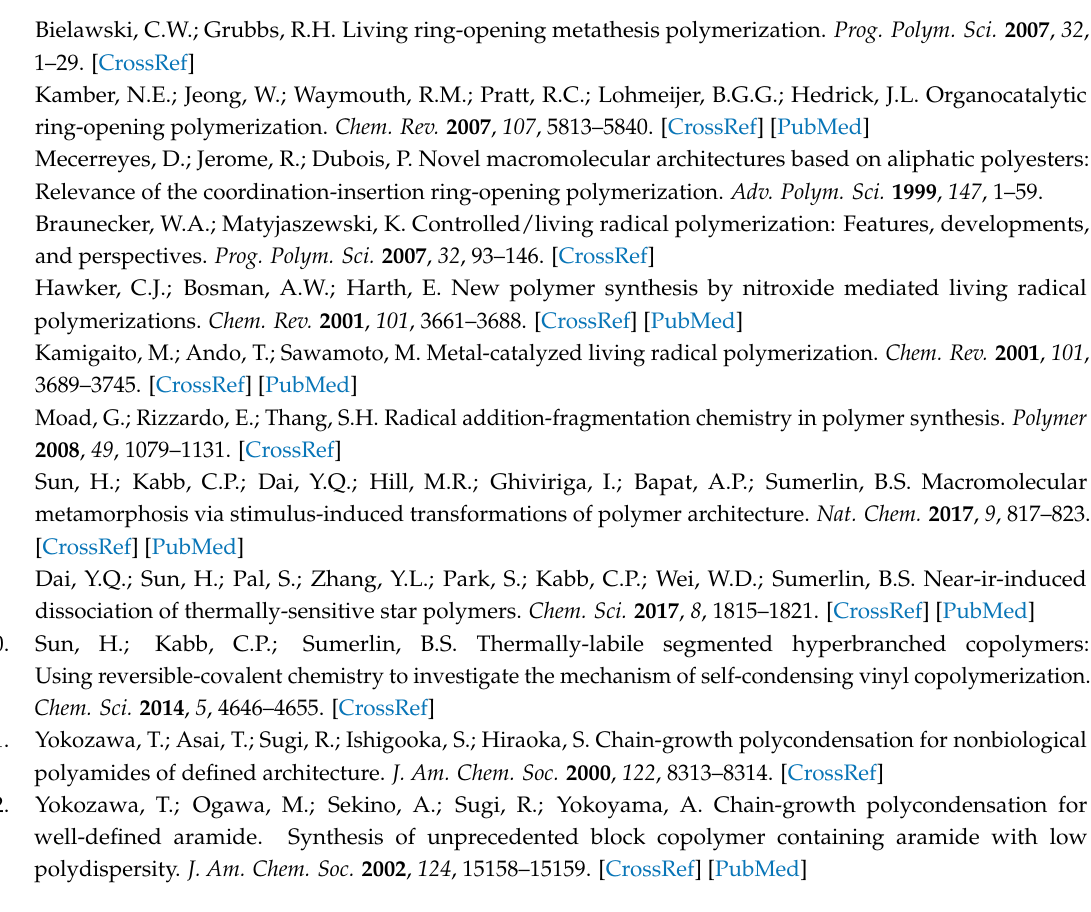
Table S1: Various inserted VBC units after SA ATRC of PCL–Br: estimated (Cal.) and measured (Exp.) m / z values in Figure 3, Table S2: Summary of rate constants based on initiators of EBiB, BzCl, and PEBr and monomers of MMA and St, Scheme S1: Reaction mechanisms of SA ATRC, Figure S1: FT-IR spectra of (a) PCL, (b) PCL- µ -PSt, and (c) PCL- µ -PtBA (co)polymers, Figure S2: FT-IR spectra of (a) PCL, (b) PCL- µ -PtBA, and (c) PCL- µ -PAA